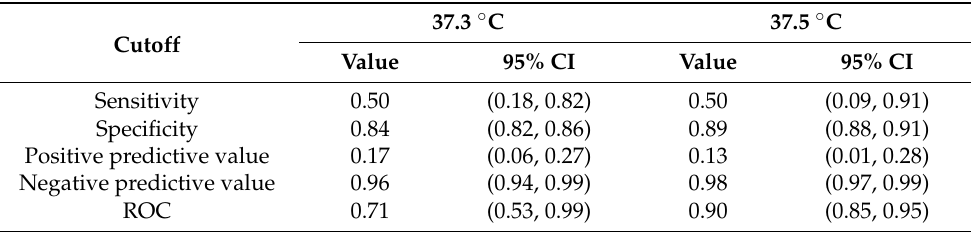
Table 4. Comparison of sensitivity, specificity, positive predictive value and negative predictive value, and the receiver operating characteristic (ROC) of the smart